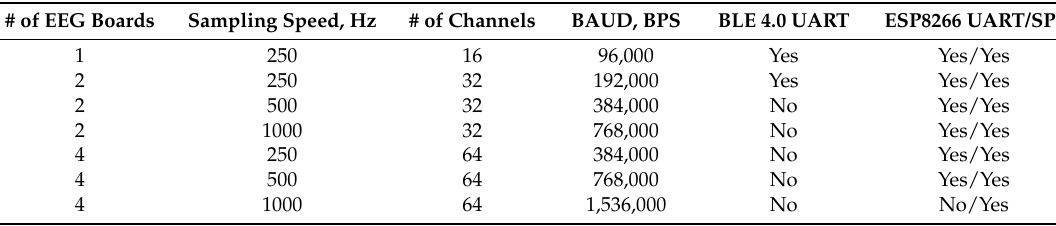
Table 3. Bandwidth requirements for raw electroencephalogram (EEG) data.